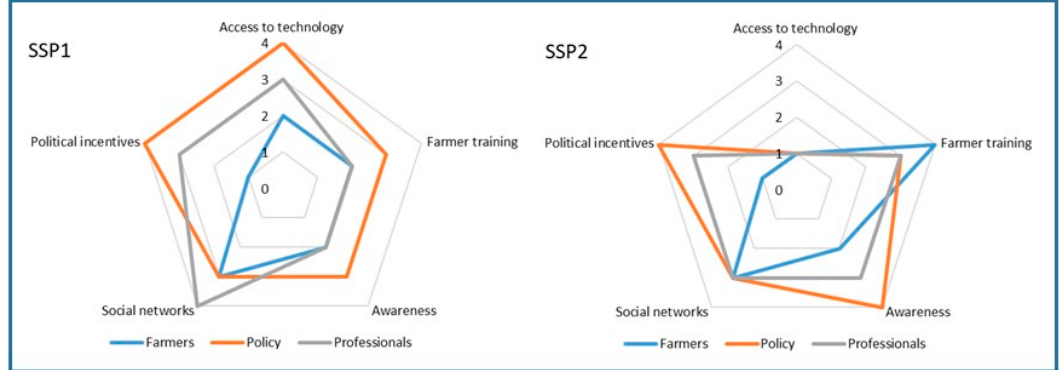
Figure 5. Main facilitators assessed during the second process of interviews of SSPS.